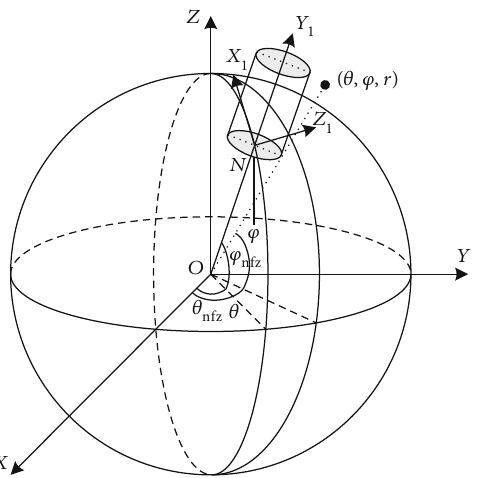
Figure 1: Schematic of a no- fl y zone